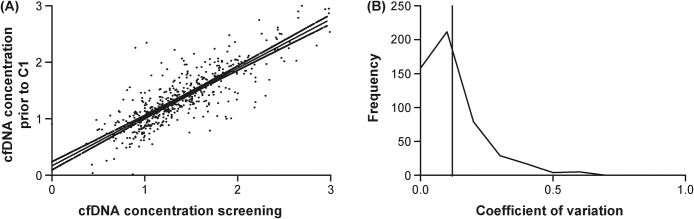
Correlation and coefficient of variation (CV) between both baseline samples taken between 1 and 7 d apart. (A) Relationship between log10-transformed cfDNA concentration (ng/ml) at screening and at C1 in 507 paired samples derived from n = 571 patients. Correlation coefficient = 0.84 (Pearson's rho) with p < 0.001. (B) CV of baseline samples depicted in a frequency chart with mean and median CV of 0.12 and 0.08 with 95% CI of 0.11 and 0.13, respectively. Mean CV is shown in solid line. C = cycle; cfDNA = cell-free DNA; CI = confidence interval; CV = coefficient of variation.